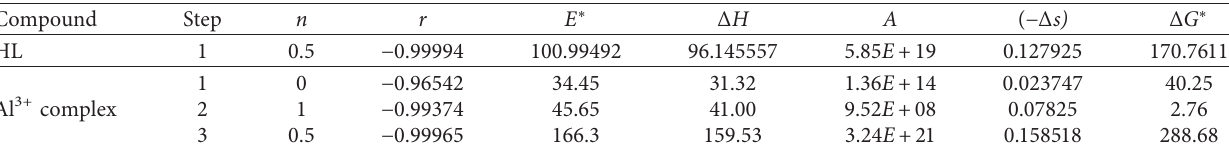
Figure 6: Thermal gravimetric analysis of HL (a) and Al +3 complex (b). Table 2: The kinetic and thermodynamic data of the thermal decomposition of HL and Al 3+ complex.